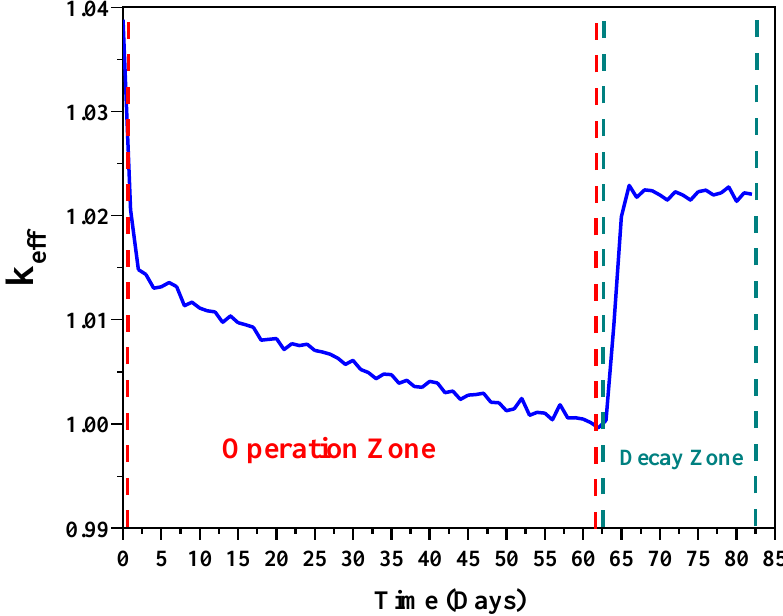
Figure 11. The burnup time versus the k eff for the proposed MSTR-HPC.